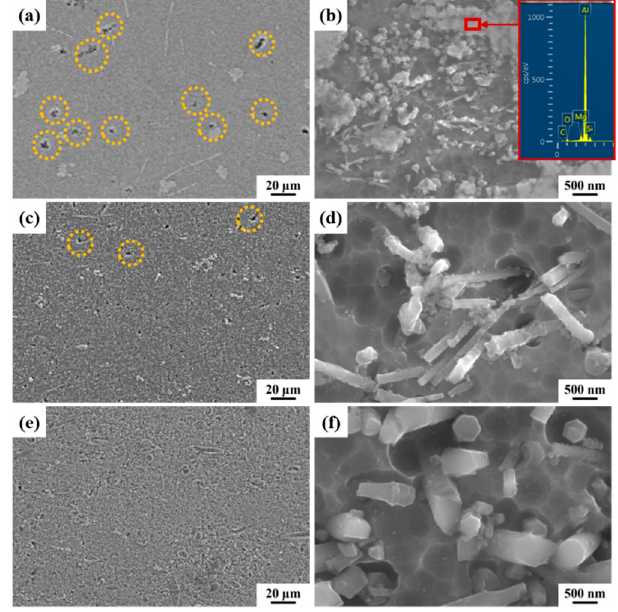
Figure 6. The representative SEM microstructure of SiCnw/6061Al composites. ( a , b ) 100D SiC- nws/6061Al, ( c , d ) 250D SiCnws/6061Al, ( e , f ) 450D SiCnws/6061Al.